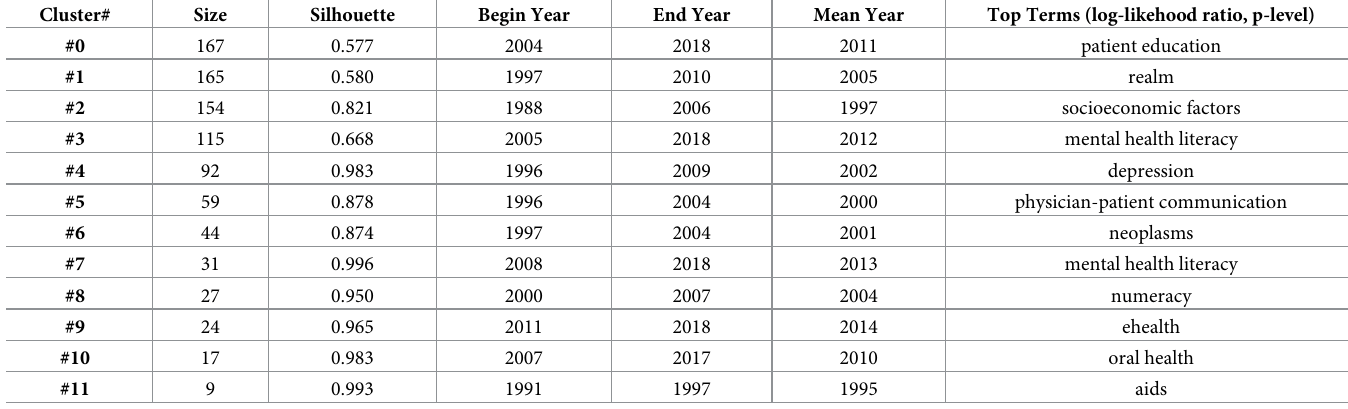
Table 6. Major clusters of co-cited references of health